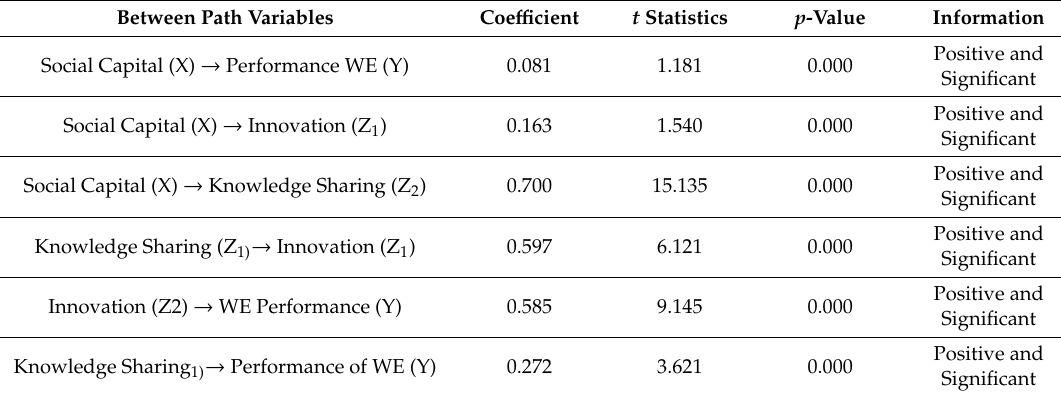
Table 4. Path Coe ffi